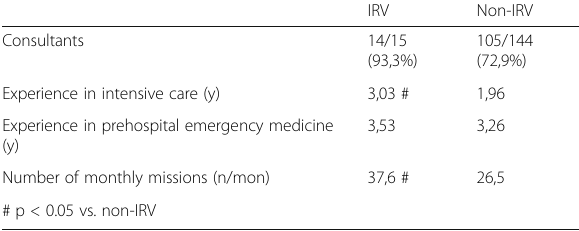
Table 2 (abstract 000230). User characteristics IRV vs.